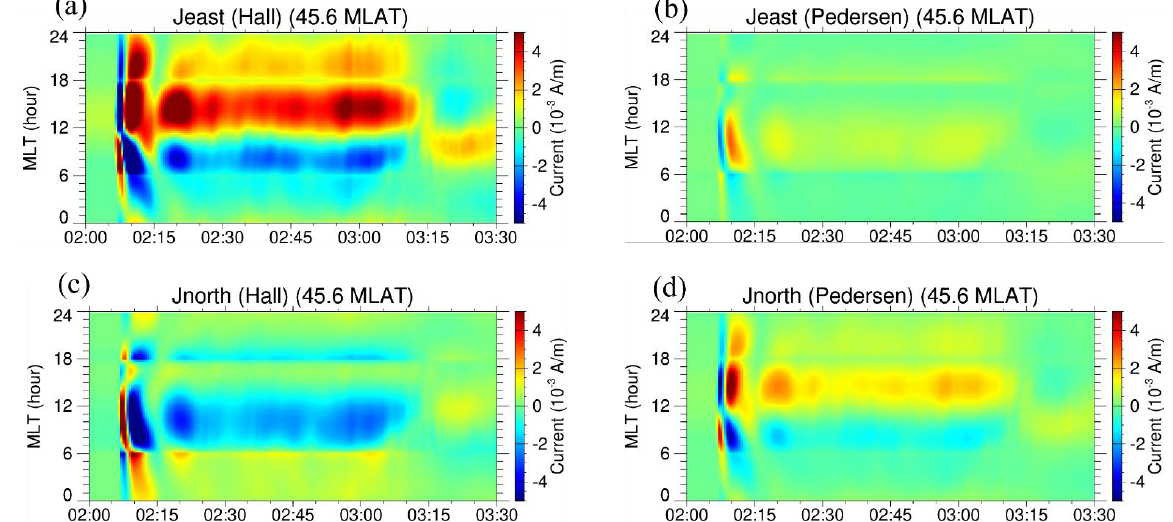
Figure 6. Ionospheric Hall and Pedersen currents at middle latitude (45.6° magnetic latitude (MLAT)), reproduced by the REPPU global simulation model. (a) and (b) show eastward (westward) Hall and Pedersen currents in red (blue) color, respectively. (c) and (d) show northward (southward) Hall and Pedersen currents in red (blue) color, respectively. The vertical axis is the magnetic local time (MLT) and the horizontal axis is the simulation time (hh:mm).